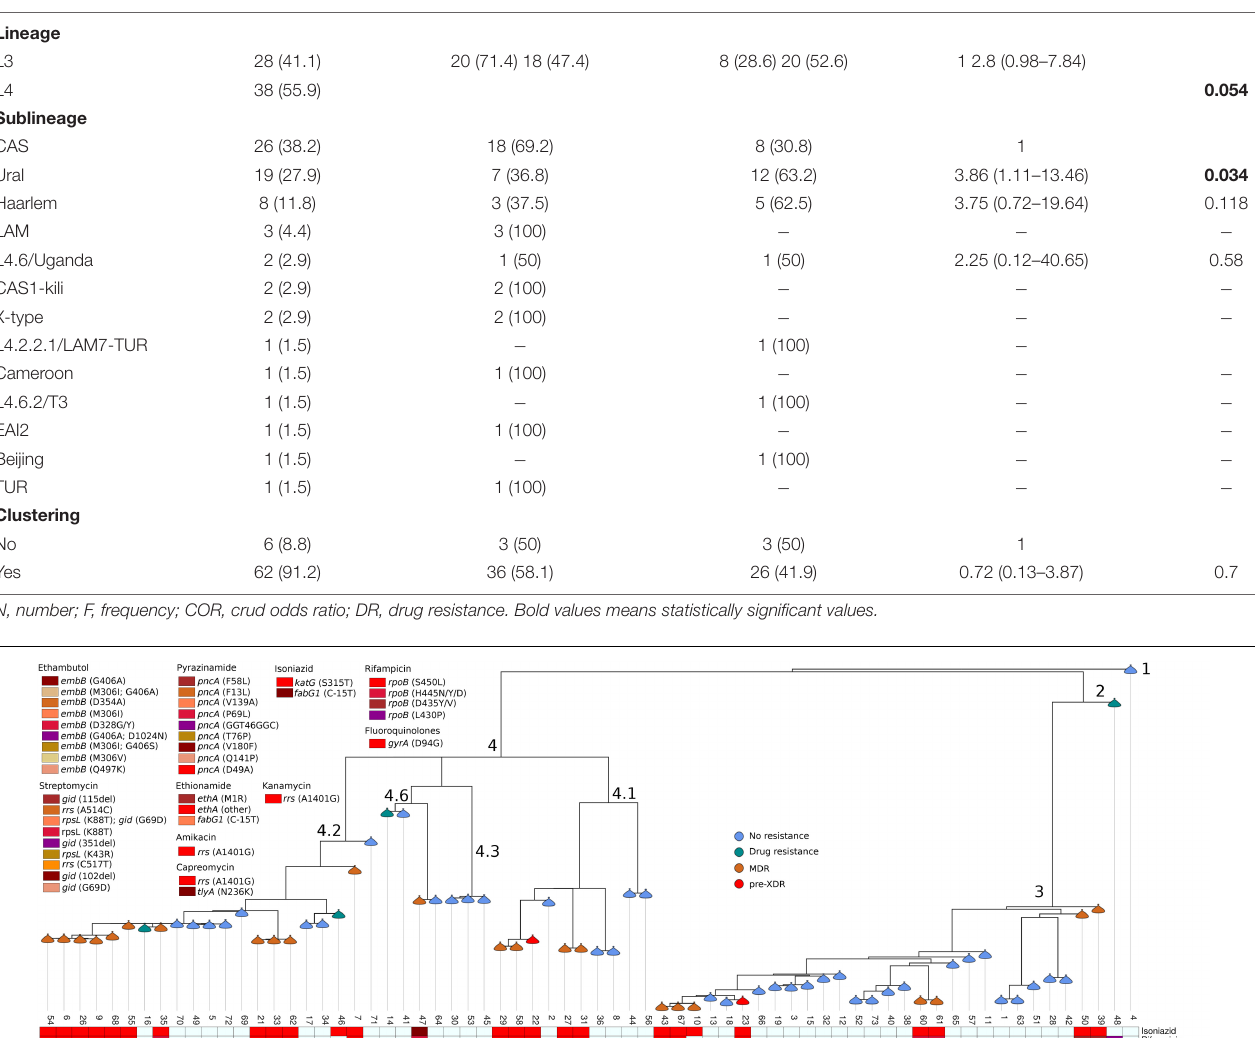
TABLE 1 | Frequency and DR association with the Mycobacterium tuberculosis strains and clustering status. Variable N (%) Pan susceptible, F (%) Any DR, F (%) COR (95% Cl) P -value